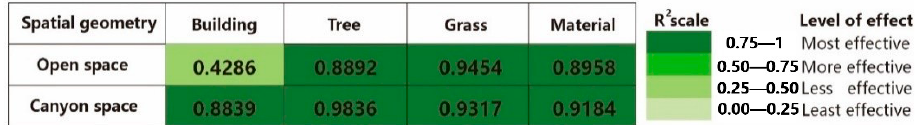
Figure 21. Correlation between thermal comfort and the coverage ratio of different parameters in canyon space at 14:00.